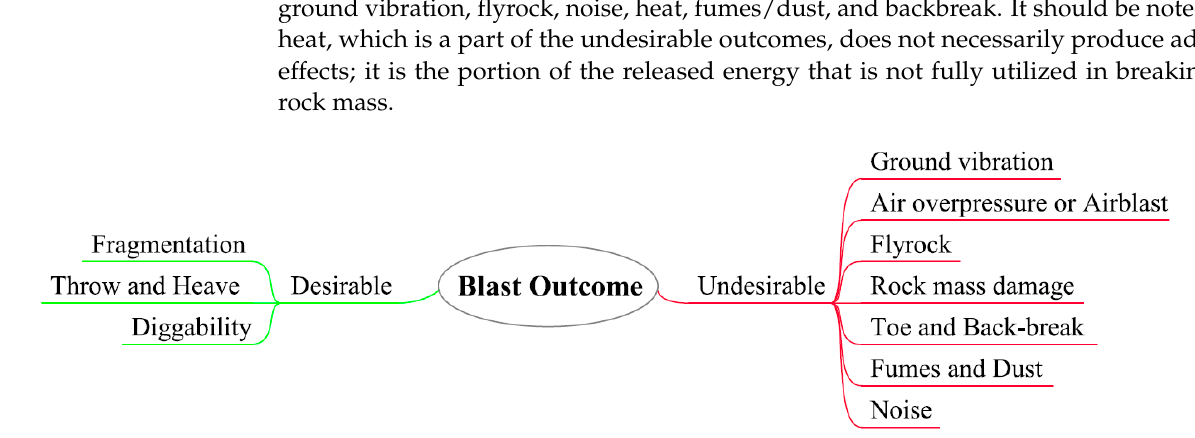
Figure 1. Desirable and undesirable outcomes of a blasting operation.